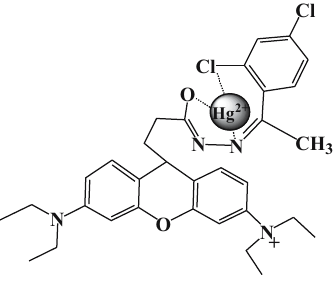
Figure 6: Possible binding mechanism of probe Rh - DCP to Hg 2 + .